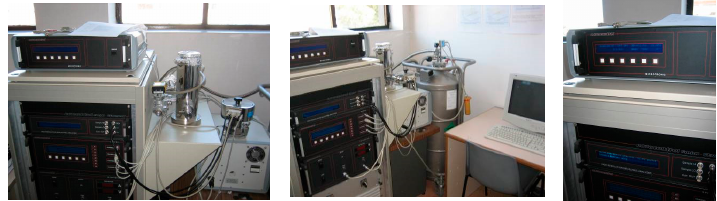
Figure 1. Dynamic Electric Analysis (DEA) equipment used with the control unit for the parameters of the test.